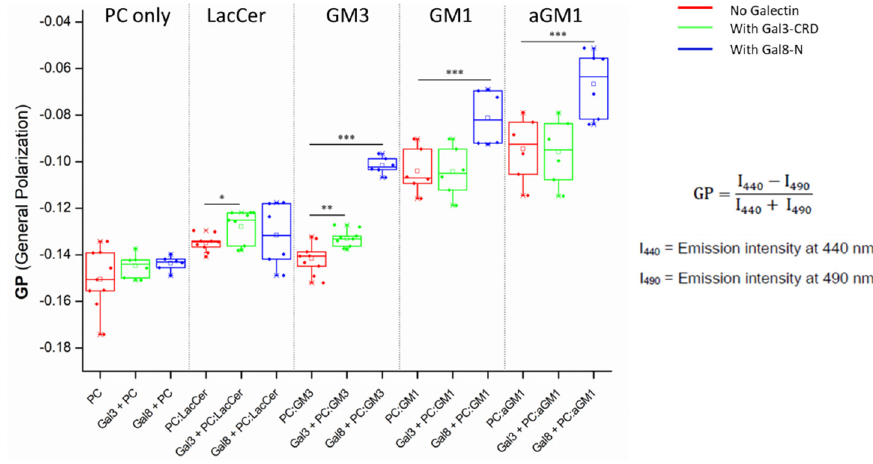
Figure 6. Laurdan GP values for membrane with/without GSLs upon the addition of Gal3 and Gal8N. Liposome content is indicated above. *** p < 0.001, ** p < 0.01, * p < 0.05 of unpaired t test.